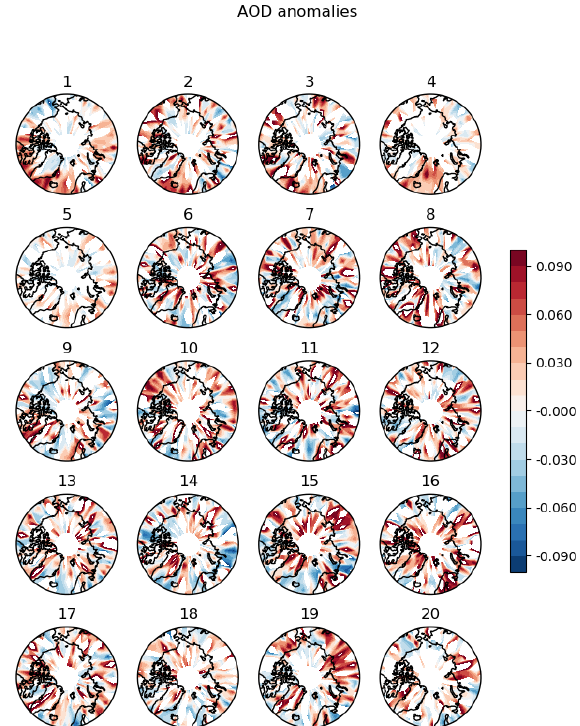
Figure A6. Tropospheric AOD anomalies based on CALIOP-CALIPSO data for the 20 circulation types. Only those anomalies that are statistically significant at the 90% confidence level are shown.